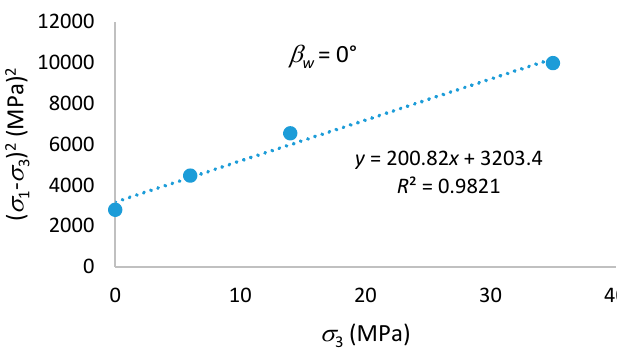
Figure A4. Regression line used to calculate the instantaneous parameters of the Hoek and Brown criterion.